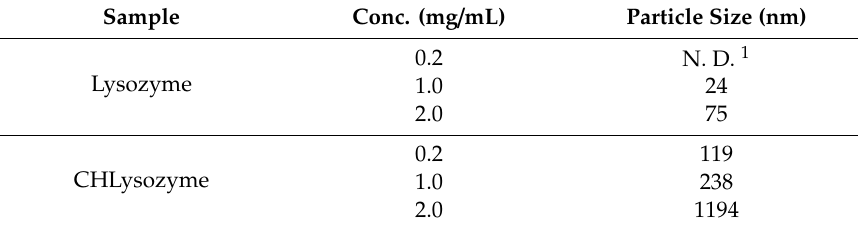
Table 1. Particle size of lysozyme and CHLysozyme with their increasing concentration.